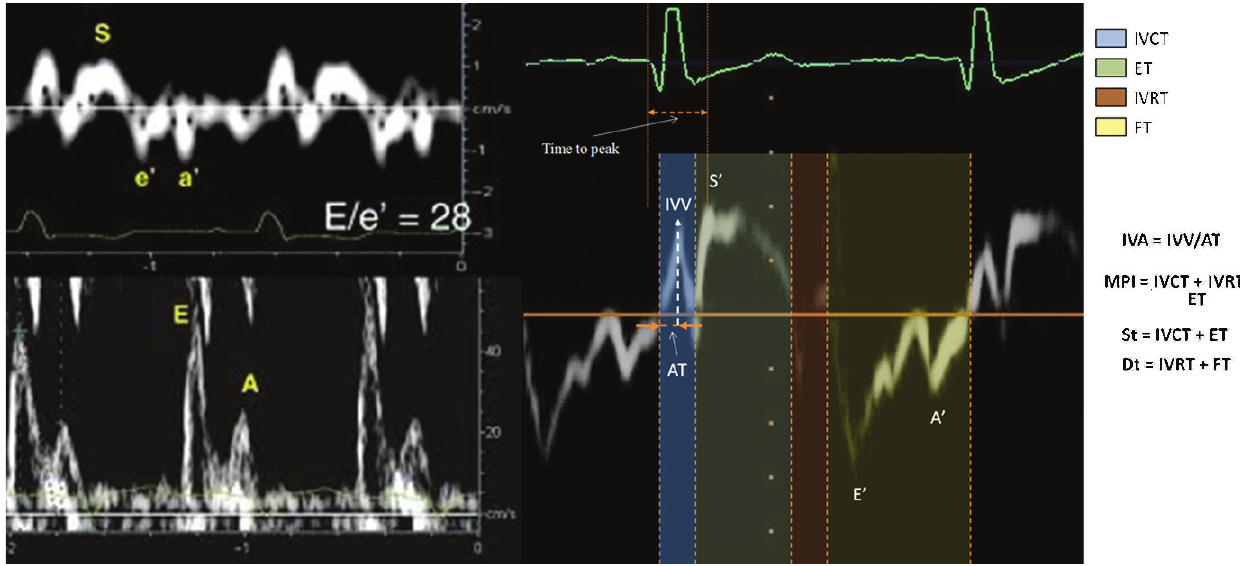
Figure 1 - ( upper left panel ) TDI parameters: systolic velocity (S’), early (E’) and late (A’) diastolic velocities. ( Lower right panel ) PW- Doppler transmitral velocities: peak velocities of transmitral early (E) and late diastolic (A) LV filling. The transmitral to mitral annular early diastolic velocity ratio (E/E’) was calculated. ( Right panel ) time to regional peak systolic velocity (TP: the beginning of the QRS complex was used as the reference point), systolic time (St: the end of the A’ wave to the end of the S wave) and ejection time (ET: the start of the S wave to the end of the S